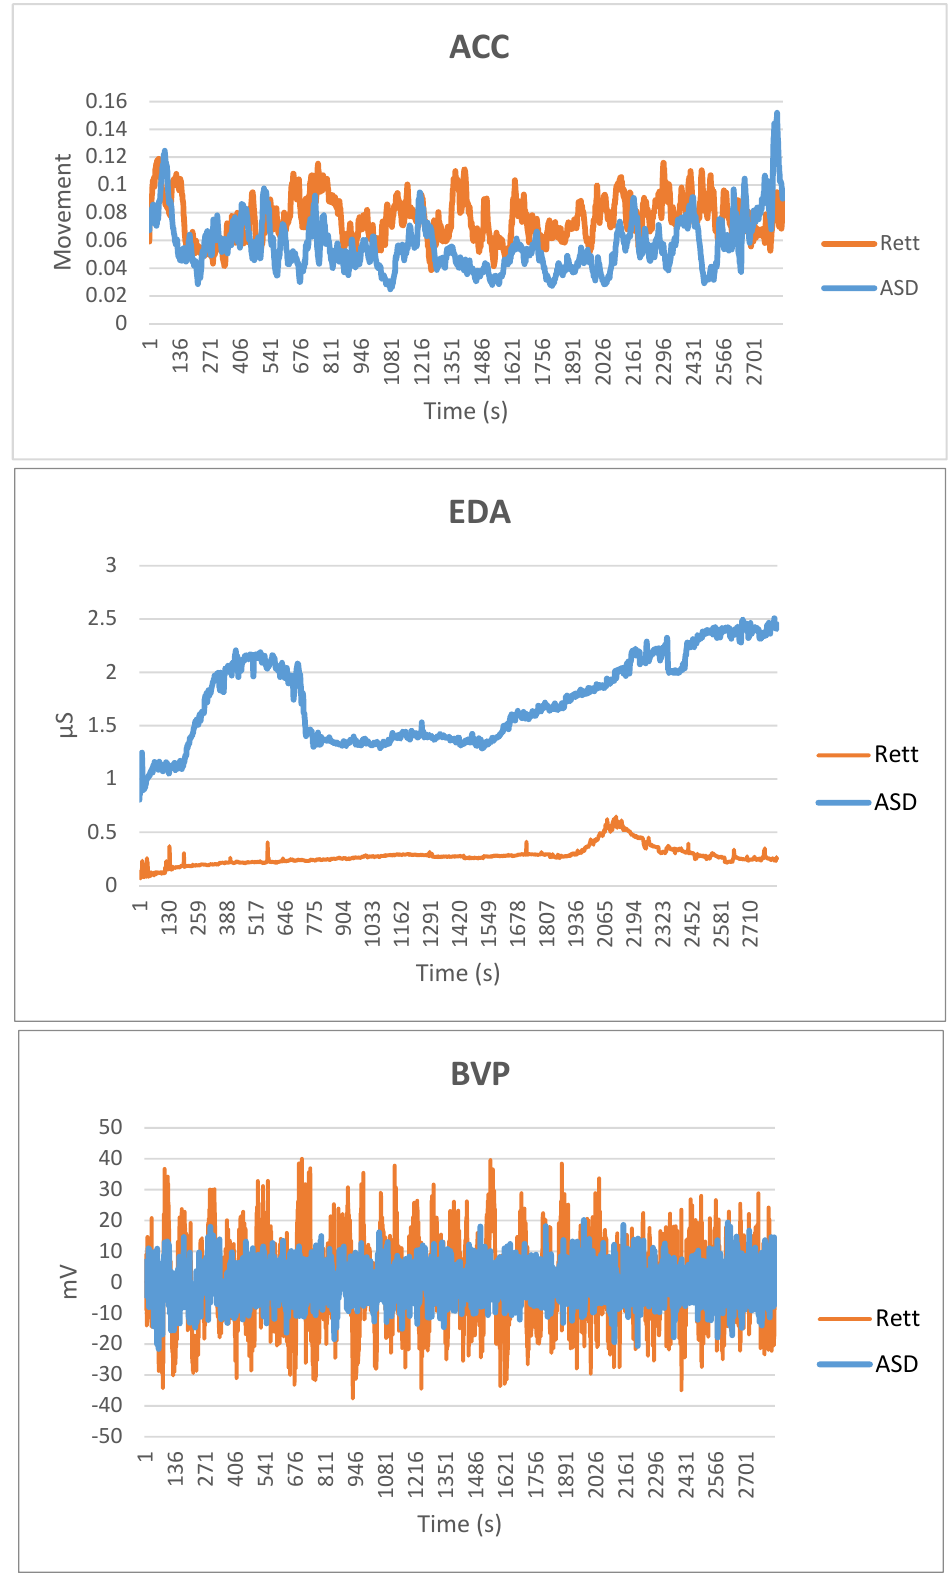
Figure 3. Average group values of ACC, EDA, and BVP in ASD vs. Rett syndrome patients. Abbreviations: ACC (Accelerometers); BVP (Blood Volume Pulse); EDA (Electrodermal Activity).